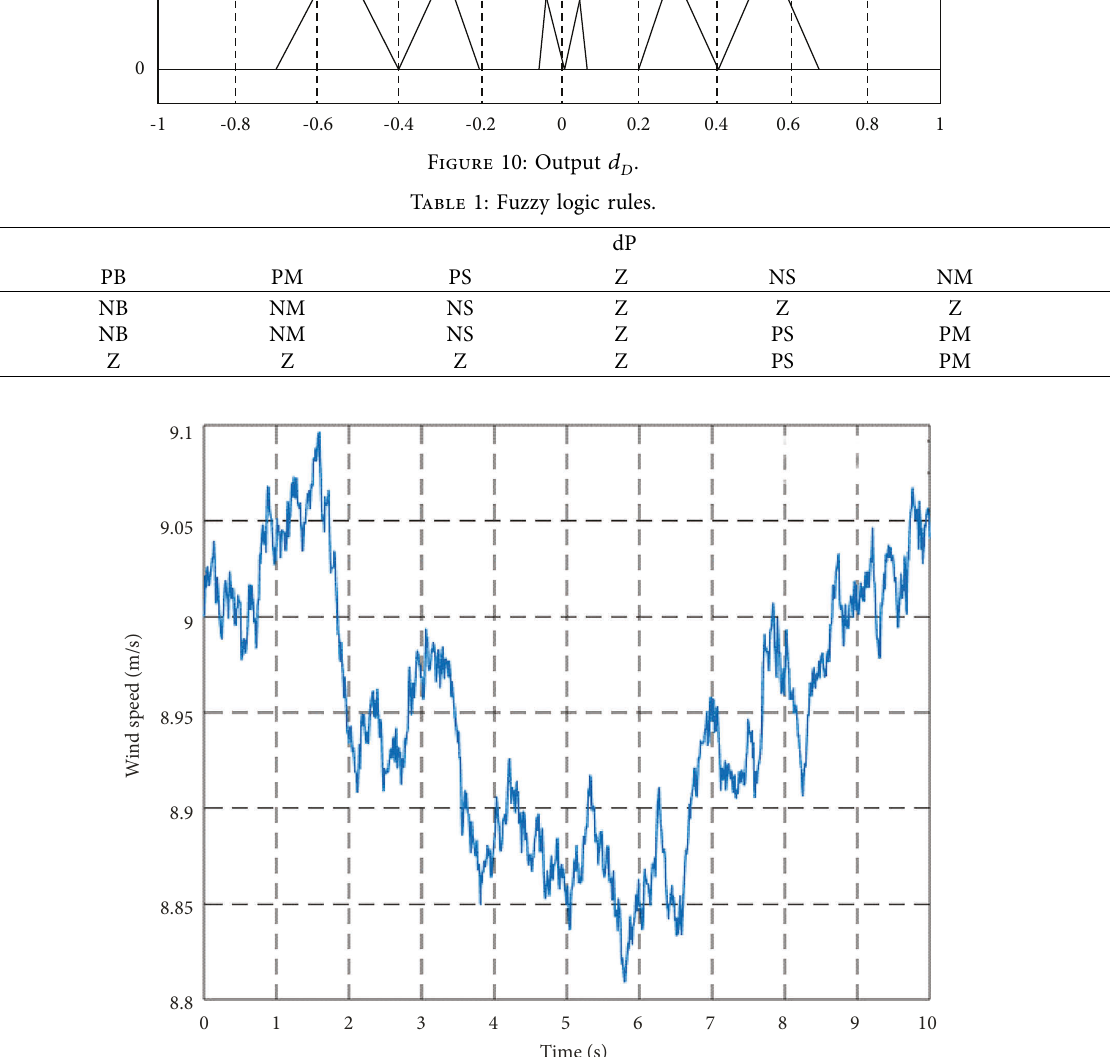
Figure 11: Wind speed